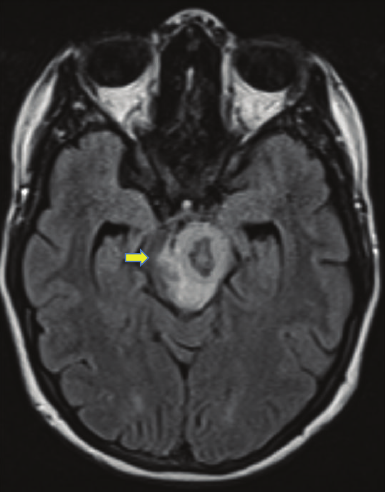
Figure 8: Tuberculoma after 2 months (horizontal